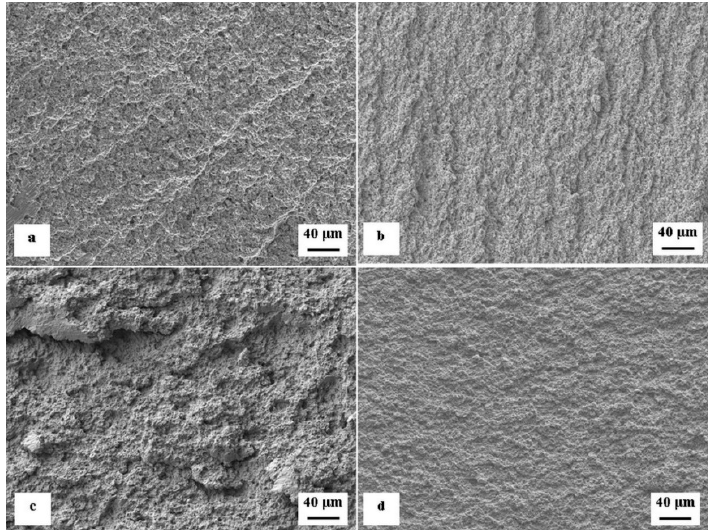
Figure 9. SEM micrographs showing the fracture surfaces of the specimens for flexural strength after tempering at 170 °C: ( a ) CHT, ( b ) SZT at − 140 °C, ( c ) SZT at − 196 °C, and ( d ) SZT at − 269 °C.